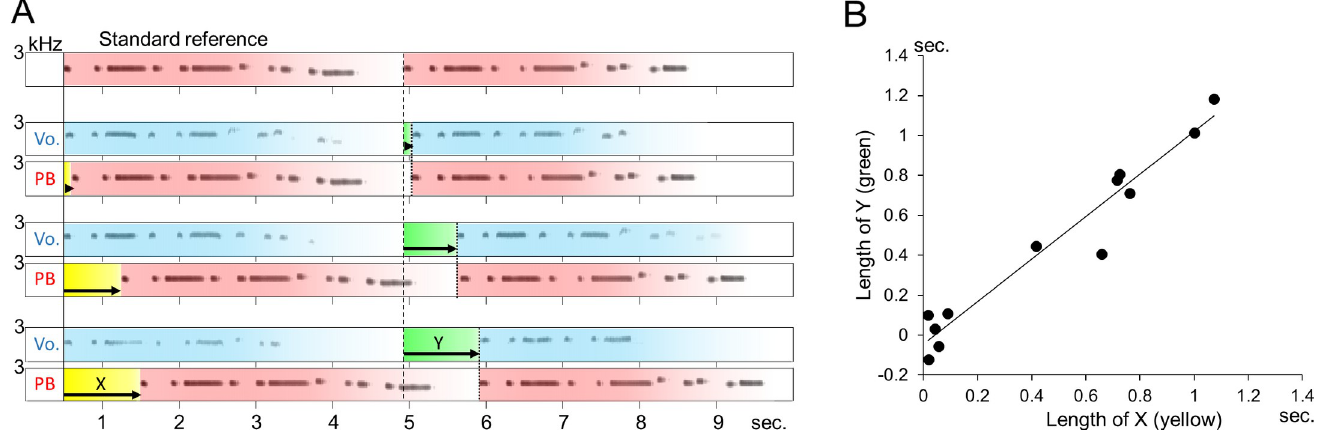
Fig 1. Effects of playback sounds on ongoing singing. These recordings were obtained from bird C (the same recordings are shown as C#3, C#4 and C#6 in S1 File ). Model sounds (PB: playback, pink shading) were played back after the bird began singing (Vo.: blue shading). Yellow shading indicates the latency of the playback sound (X). Green shading indicates the duration between the onset of the second half of the standard reference (see main text) and the actual onset of the second half of singing (Y). Note that the onset of the second half of the playback sound and the singing started at nearly the same time (A). Correlation between the length of X and the length of Y is shown in Fig 1A. Each dot denotes values of X and Y obtained from a recording that includes bird singing and playback of the melody. When the length of X is longer, the length of Y is longer (B).